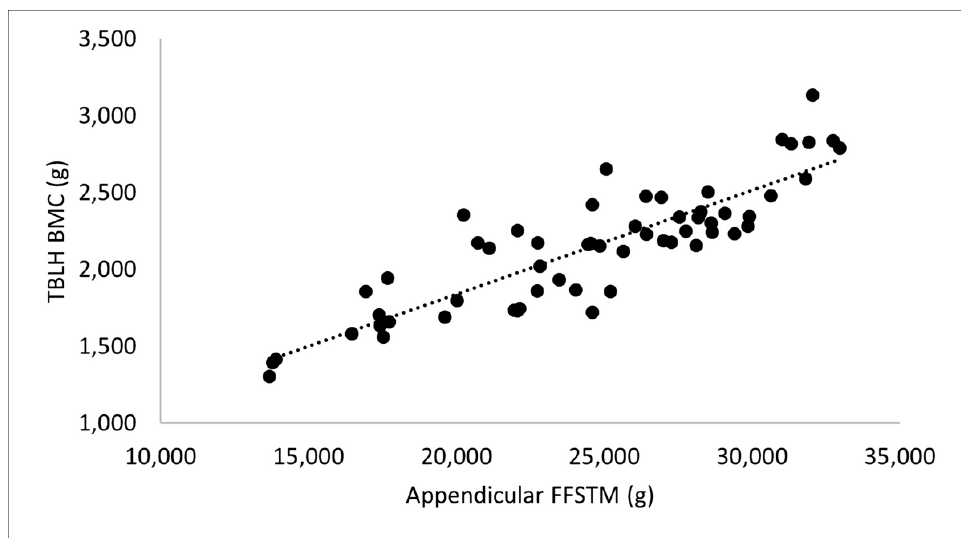
Figure 3. Relationship between appendicular fat-free soft tissue mass and bone mineral content at the total body less head region assessed in 58 black belt karatekas competing at the national and international level. FFSTM, fat-free soft tissue mass; TBLH, total body less head; BMC, bone mineral content.